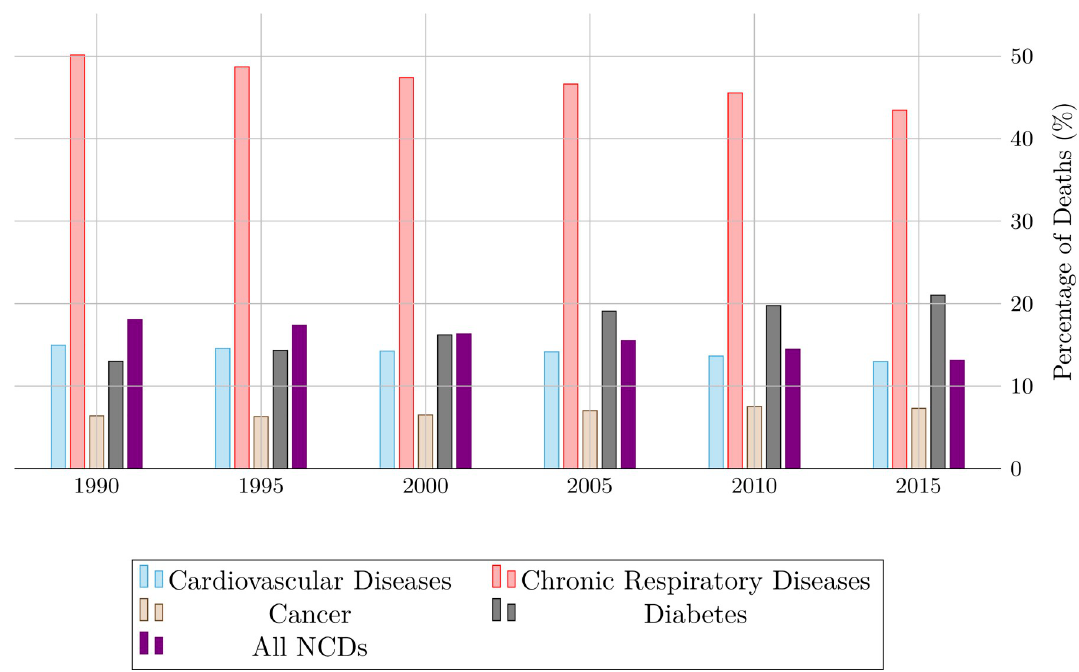
Fig 3. Percentage of deaths associated with air pollution for four disease categories, 1990–2015.